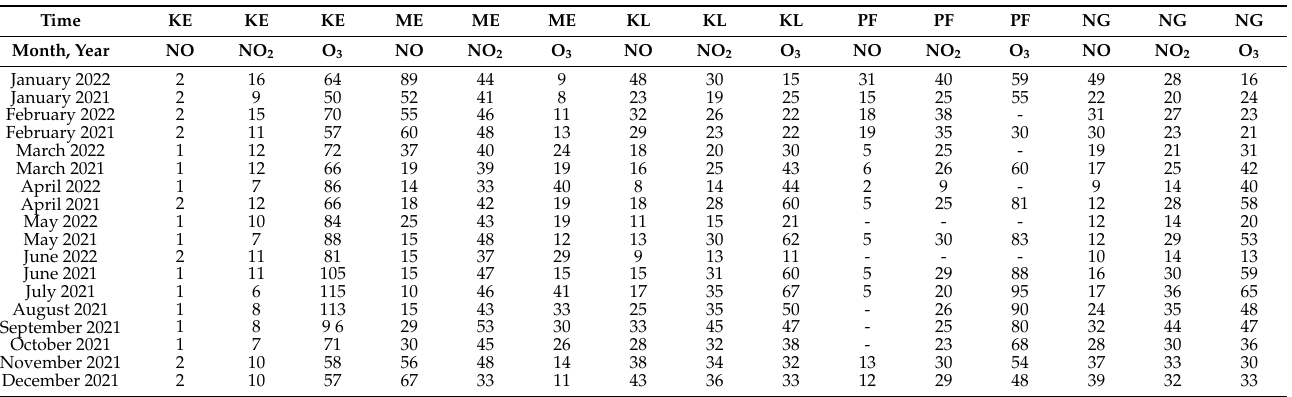
Table 5. Mean NO, NO 2 and O 3 ( µ g m − 3 ) values at the considered sites; there were no data recorded for the missing